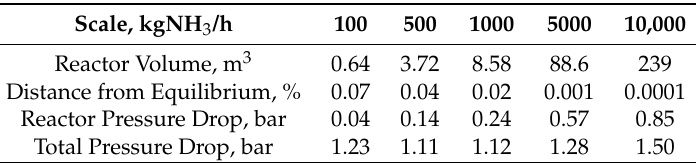
Table 11. Reaction-absorption loop